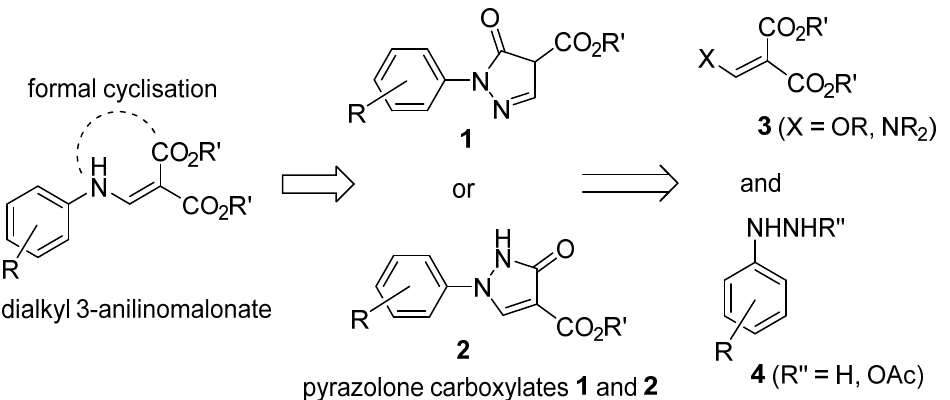
Figure 2. Dialkyl 3-anilinomalonate and its conformationally constrained pyrazolone analogues 1 and 2 .